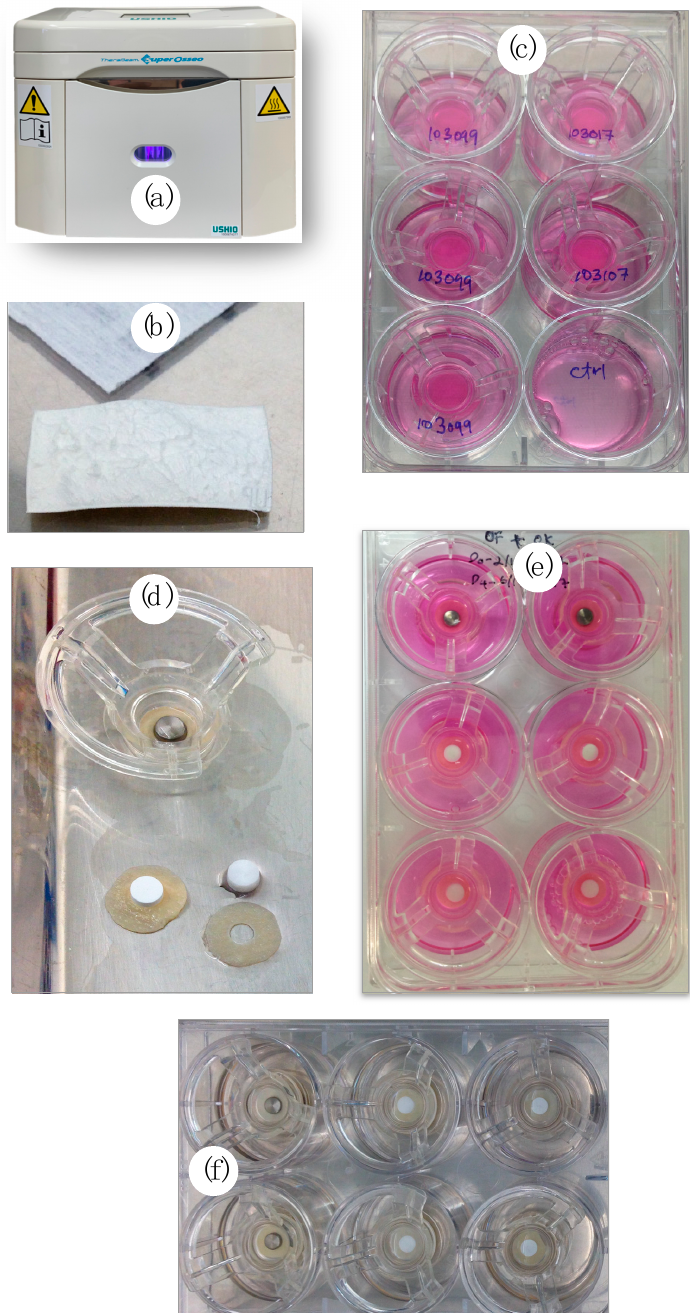
Figure 1. Steps in preparing the three-dimensional peri-implant mucosal model ( a ) the UV generating device; ( b ) membrane; ( c ) the membrane was cut into a round shape, fit in the insert with cells inoculated; ( d ) a punch hole was created in the middle of membrane and specimen inserted; ( e ) the tissue and specimens were incubated for up to ten days; ( f ) the tissues were washed with Dulbecco’s phosphate buffered saline before a permeability test was carried out.